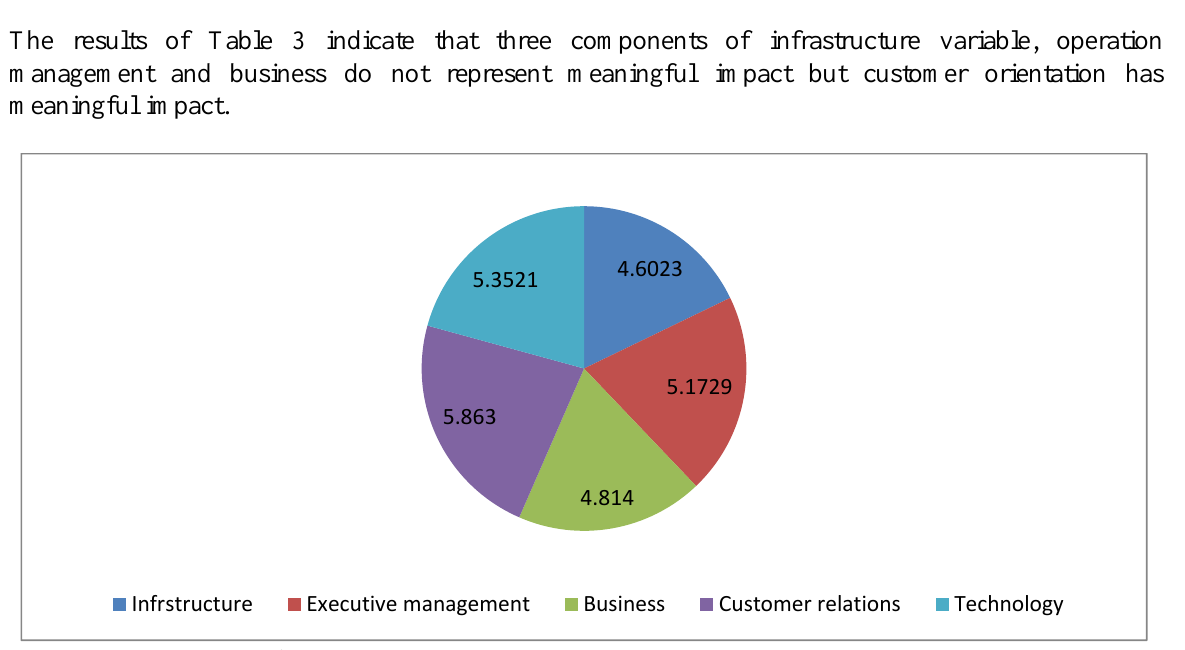
Fig. 5. The mean values of OMBOK model’s